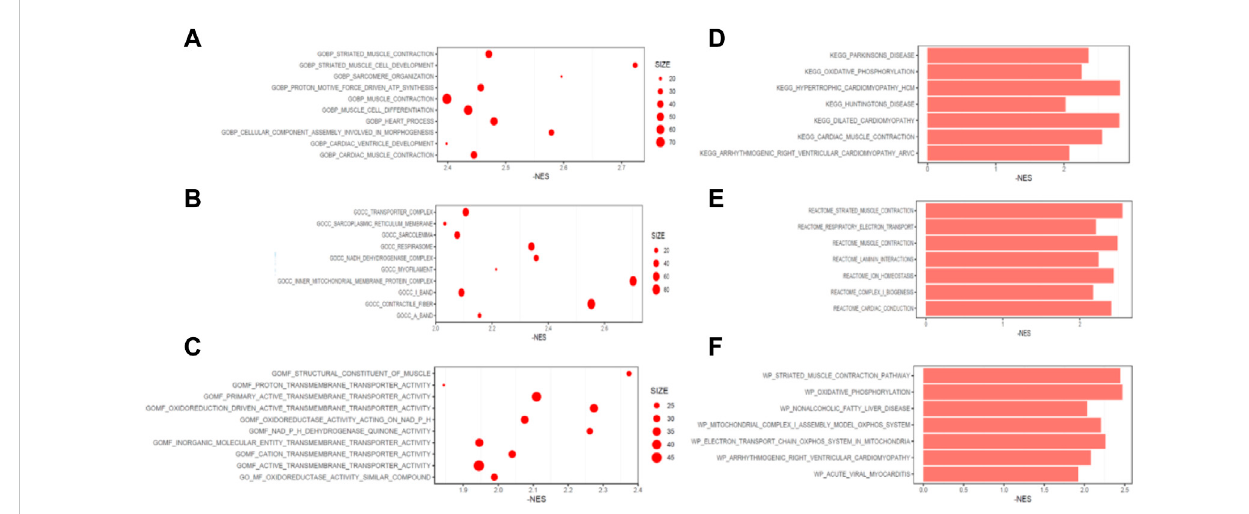
FIGURE 7 Pathways enriched of the differentially expressed proteins. Top 10 pathways enriched by GO for biological processes (A) , cellular components (B) and molecular function (C) . Top 7 pathways enriched by KEGG (D) , REATOME (E) and WIKI (F)